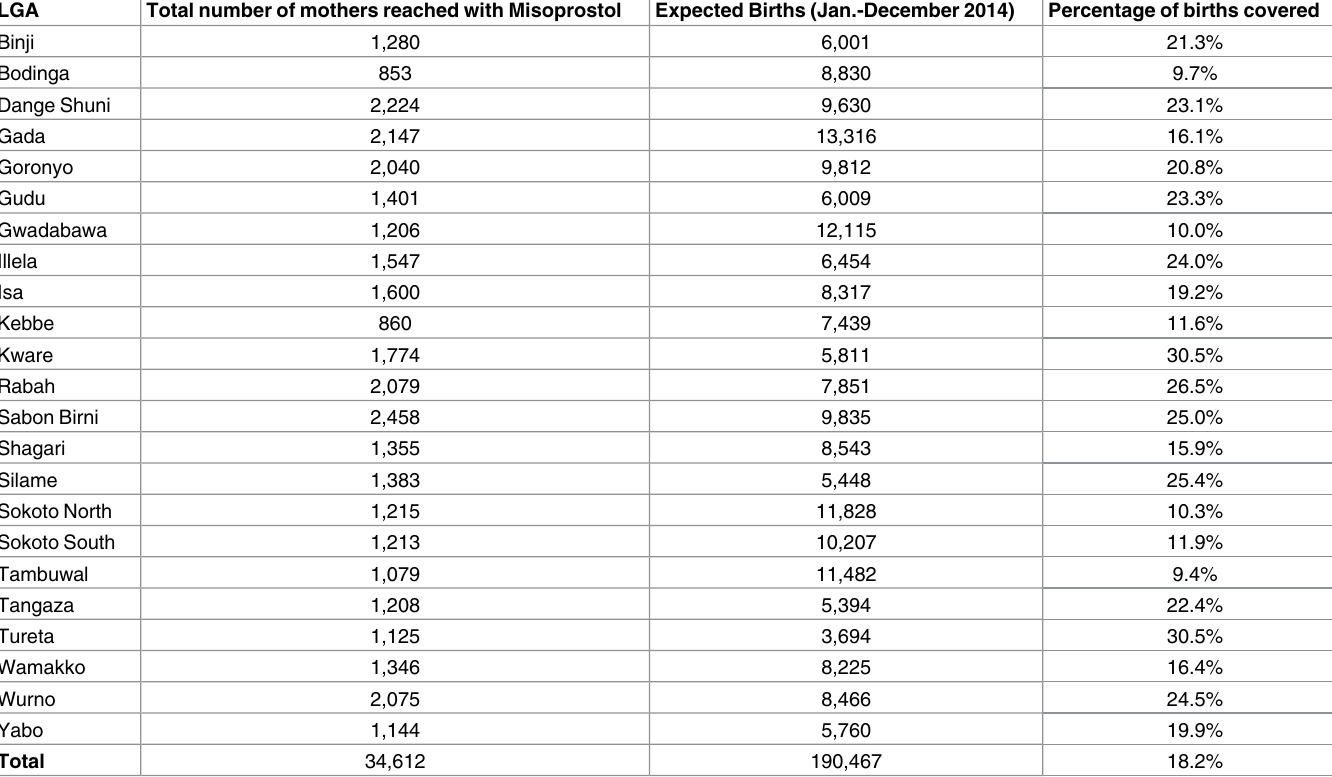
Table 3. Percentage of Births that receivedmisoprostol in each Local Government Area(LGA) in 2014. LGA Total number of mothers reached with Misoprostol